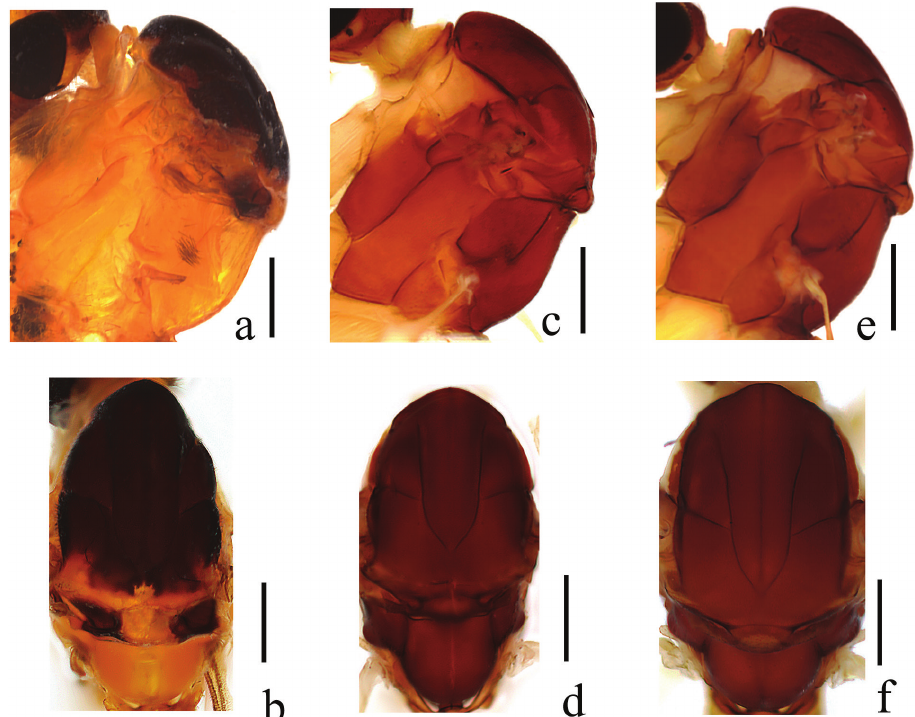
Figure 1. Thoraxes of new Ptychoptera species a P. hekouensis , dorsal view b P. hekouensis , lateral view c P. longa , dorsal view d P. longa , lateral view e P. xiaohuangshana , dorsal view f P. xiaohuangshana , lateral view. Scale bars: 0.5